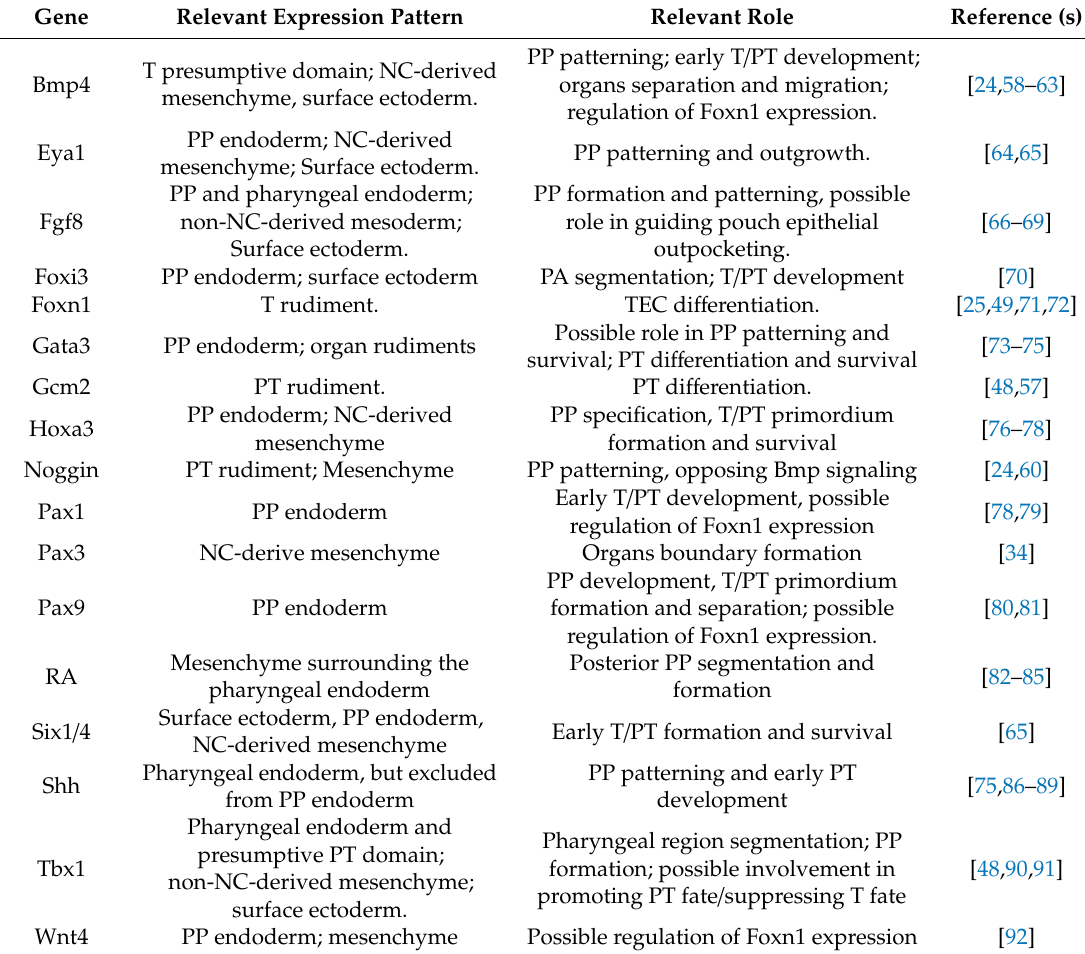
Table 1. Key signaling molecules and TFs implicated in T / PT early